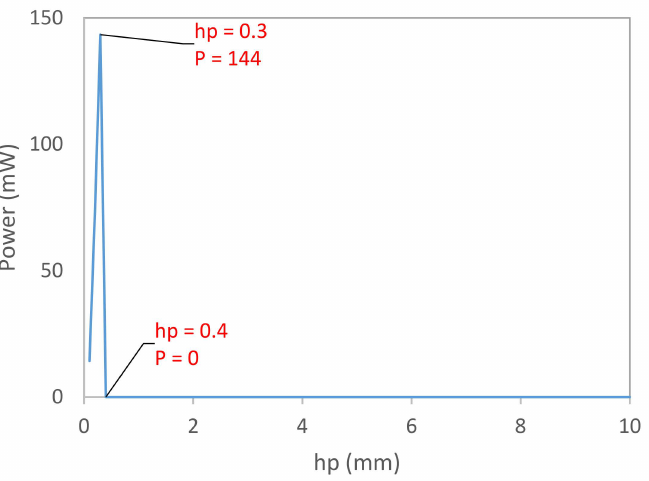
Figure 11. Graph Showing Variation of Power Output with Piezoelectric Layer Thickness h p